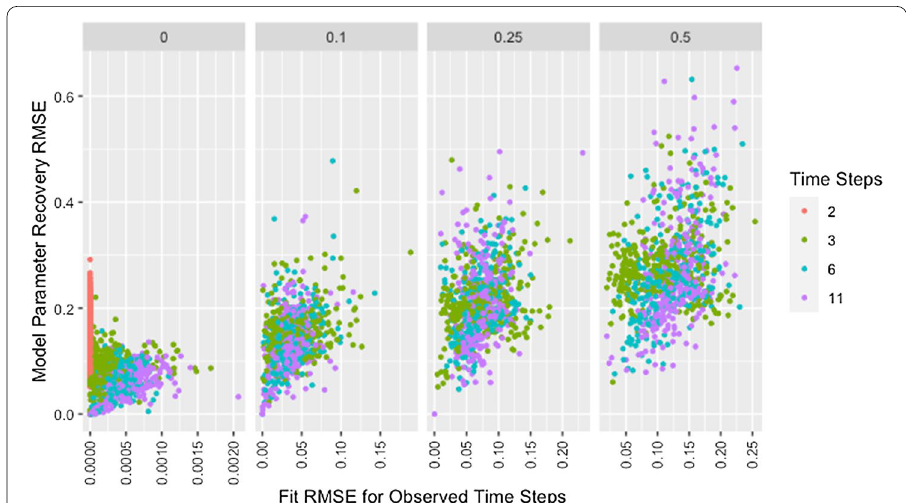
Fig. 10 RMSE for model parameter recovery by fit RMSE, time steps, and missingness. RMSE for known and predicted weights by RMSE for observed and predicted opinions on observed time steps, number of time steps, and proportion of missing data across panels with different x-axis